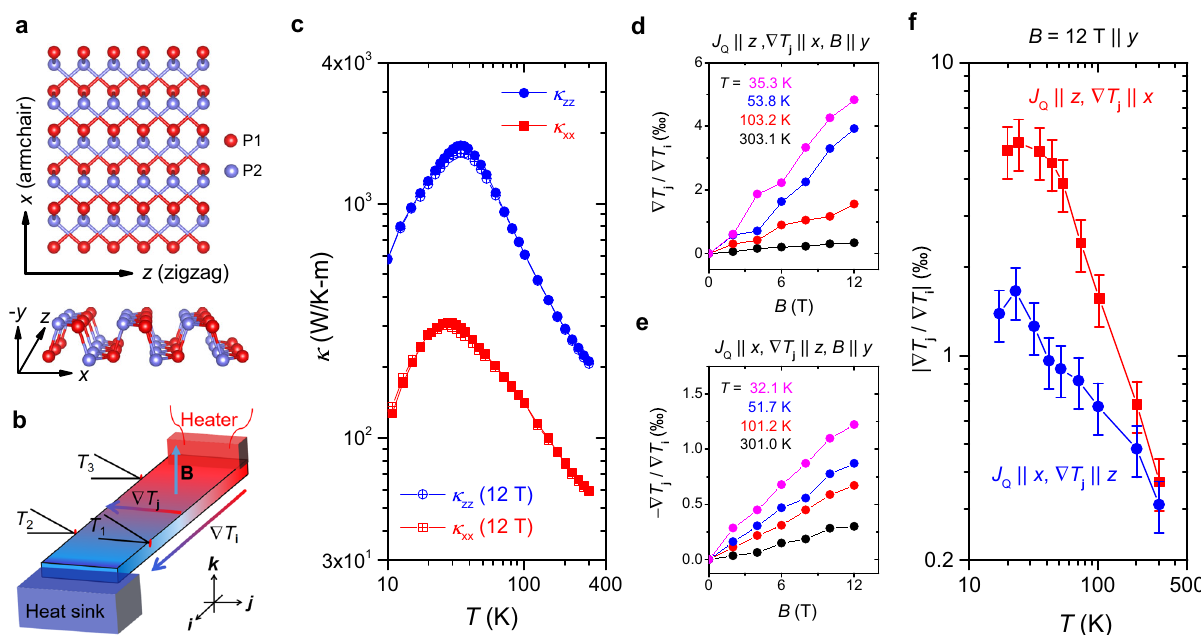
Fig. 1 | Lattice structure, setup and thermal transport. a Top (two layers) and side (single layer) view of the lattice of black phosphorus (BP). P atoms, marked in blueandred,belongwithatomicsiteswithdistinctenvironments.The x and z axes respectivelycorrespondtothearmchairandzigzagdirectionsoftheBPlayerplane. b The setup for measuring longitudinal and transverse thermal conductivities. c Thermal conductivity along the armchair ( κ xx ) and the zigzag ( κ zz ) orientations.